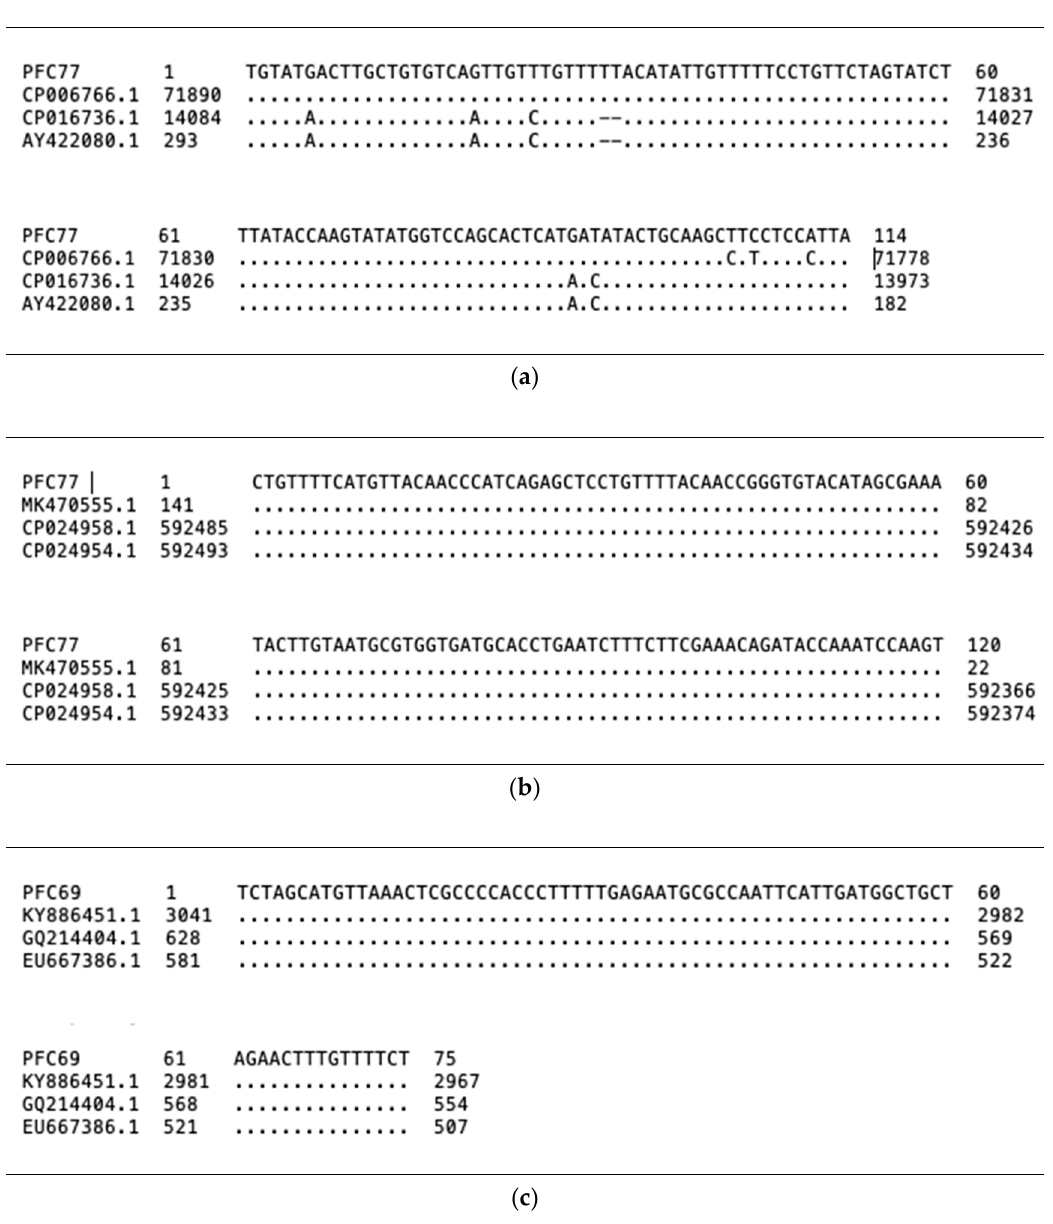
Figure 2. Sequences and homology of bacteriocin encoding genes ( a ) lcn B, ( b ) nis Z, and ( c ) ped A, amplified from the genomes of P. acidilactici PFC69 and L. lactis PFC69.